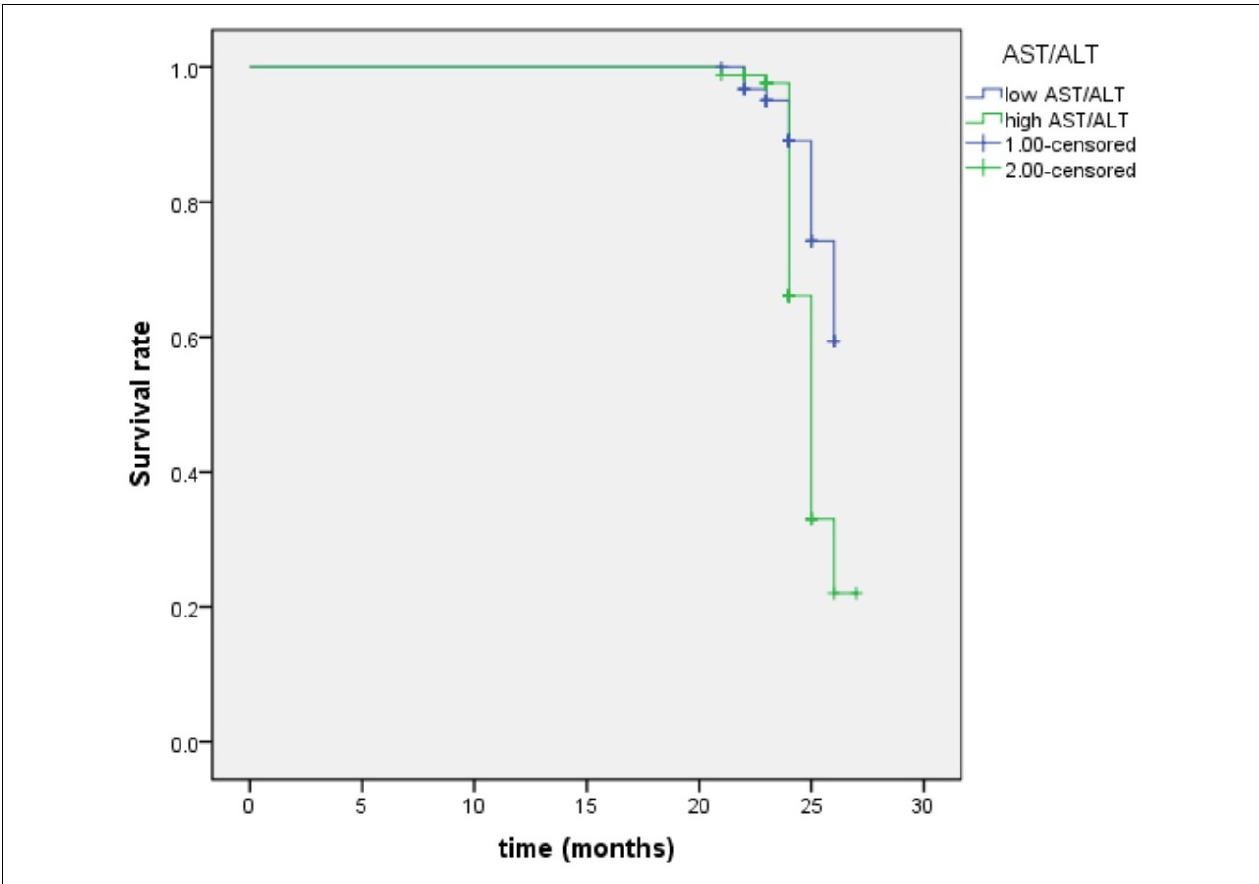
FIGURE 3 | Survival regression curve of AST/ALT ratio predicting future incidence of aMCI. AST, aspartate aminotransferase; ALT, Alanine